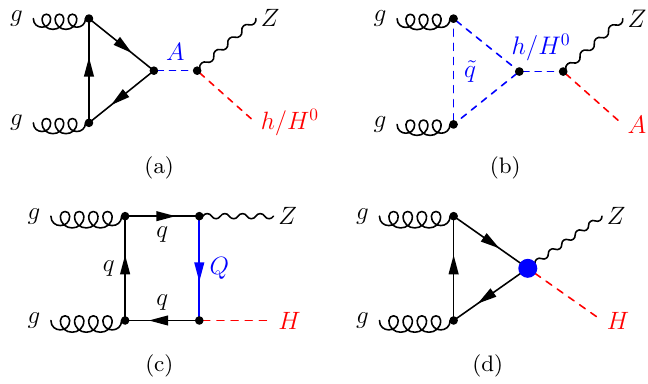
Figure 4 . Selection of new contributions to the gg ! Z(cid:30) amplitude in the 2HDM / MSSM due to (a) intermediate (pseudo)scalars and (b) squarks in addition; to the gg ! ZH amplitude in the SM due to (c) vector-like quarks and (d) dimension-6 operators.